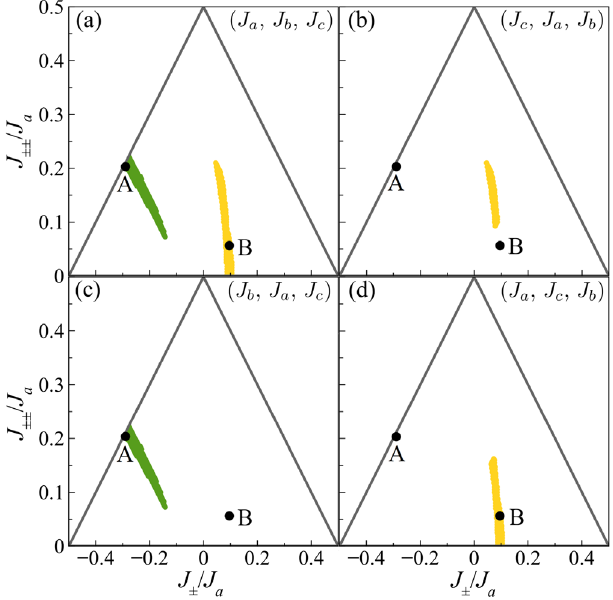
FIG. 4. (a) The goodness-of-fit parameter ( h δ 2 = ϵ 2 i fourth-order NLC calculation compared to the measured C a function of the exchange parameters, J and J ¼ 1 4 ð J b − J c Þ . This displays two local minima of (cid:3)(cid:3) . The best-fit parameters are labeled as parameter h δ 2 = ϵ 2 i C mag set A and parameter set B. The global minimum corresponds to set A while set B is only locally optimal. (b) The best-fit parameters from the NLC calculations (A and B) overlaid on the zero-field ground-state phase diagram predicted for the XYZ model Hamiltonian and DO pyrochlores [10]. The set A exchange parameters are well within the region of the phase diagram that is attributed to the U ð 1 Þ π QSL, while the set B parameters are well within the region attributed to an ordered ground state.